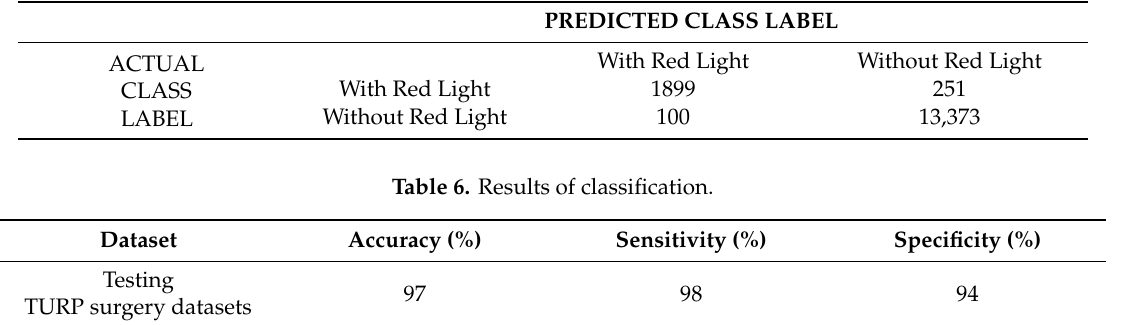
Table 5. Confusion matrix of testing TURP surgery datasets.